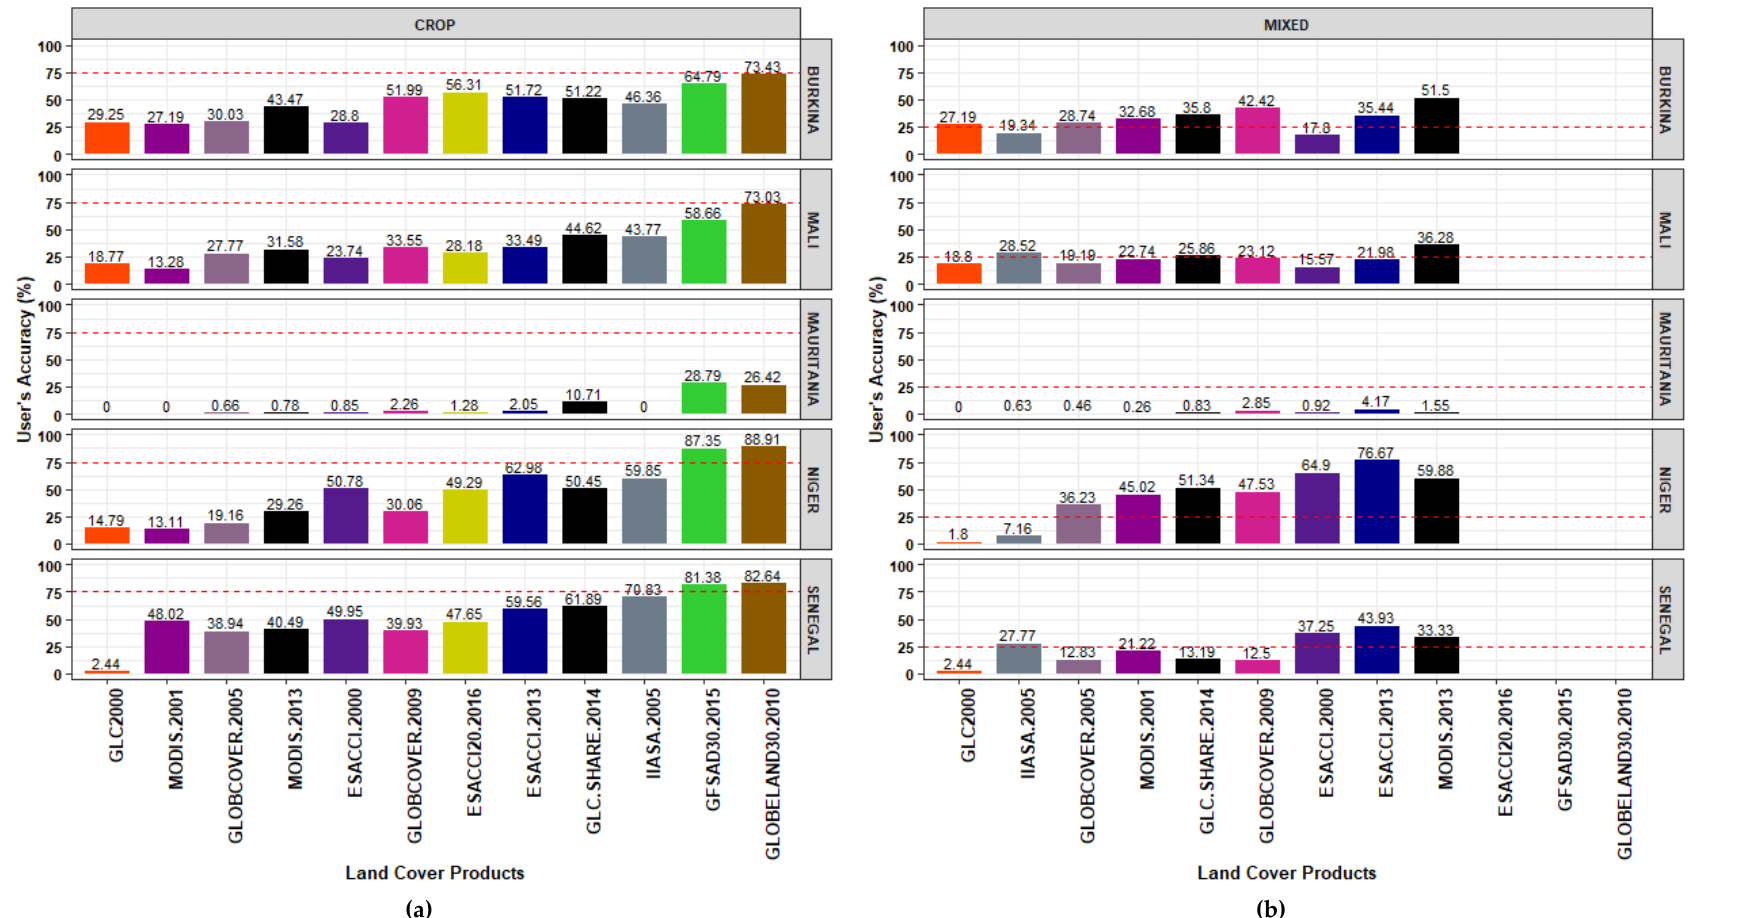
Figure 6. User’s accuracy for crop ( a ) and mixed crop ( b ) classes. ESACCI 20 m, GFSAD30, and GlobeLand30 do not have mixed crop class ( b ).